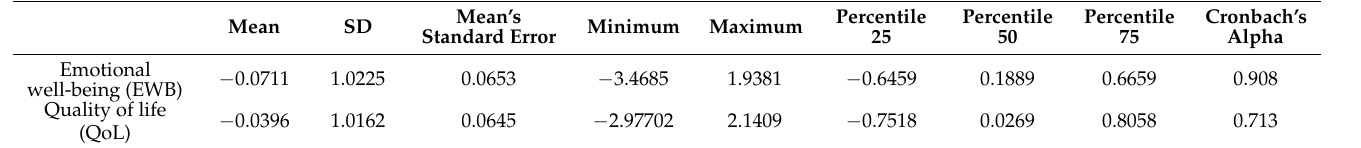
Table 3. Factors’ standardized